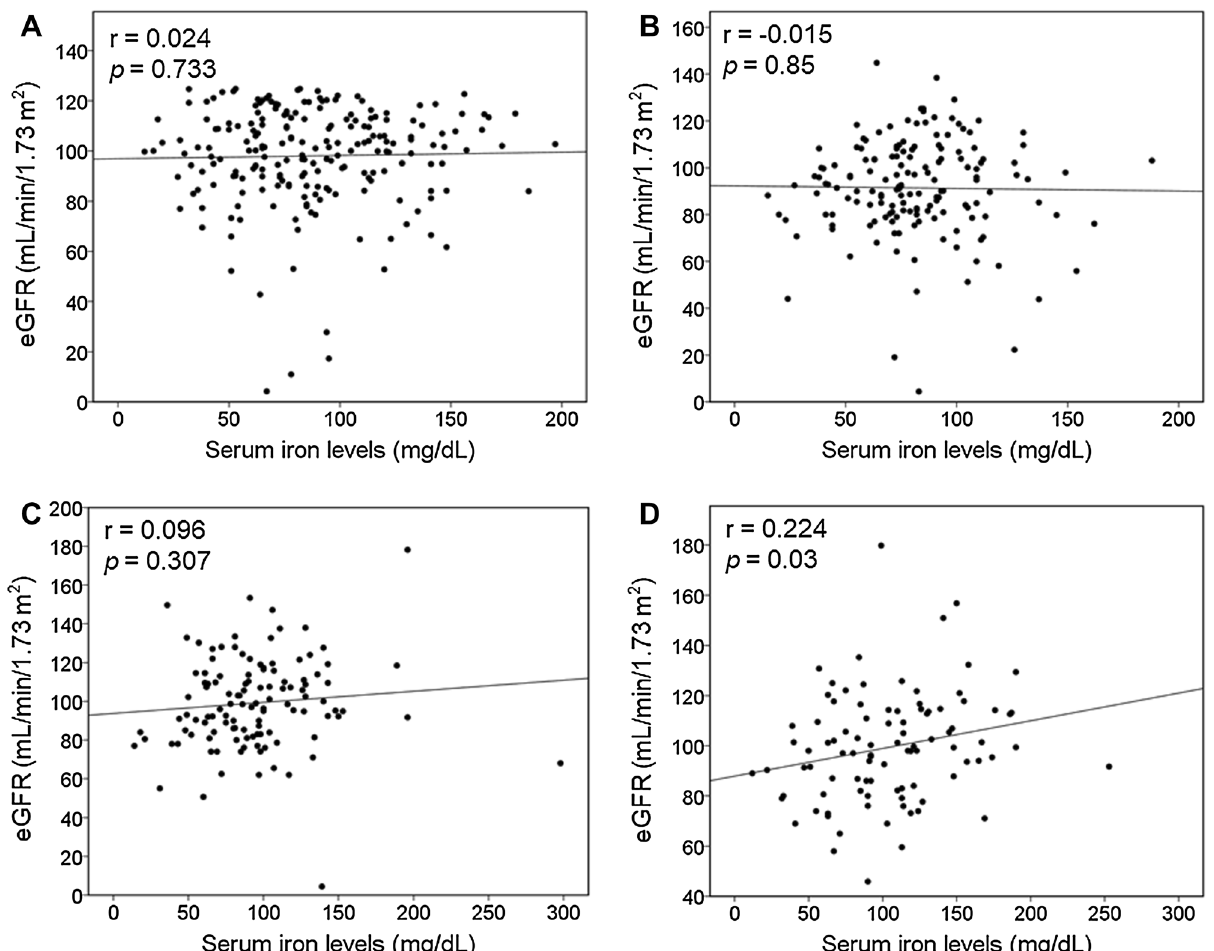
Figure 2. The associations of serum iron concentrations with renal function (i.e., estimated glomerular filtration rate) at ( A ) baseline and ( B ) 1, ( C ) 6, and ( D ) 12 months following laparoscopic sleeve gastrectomy.